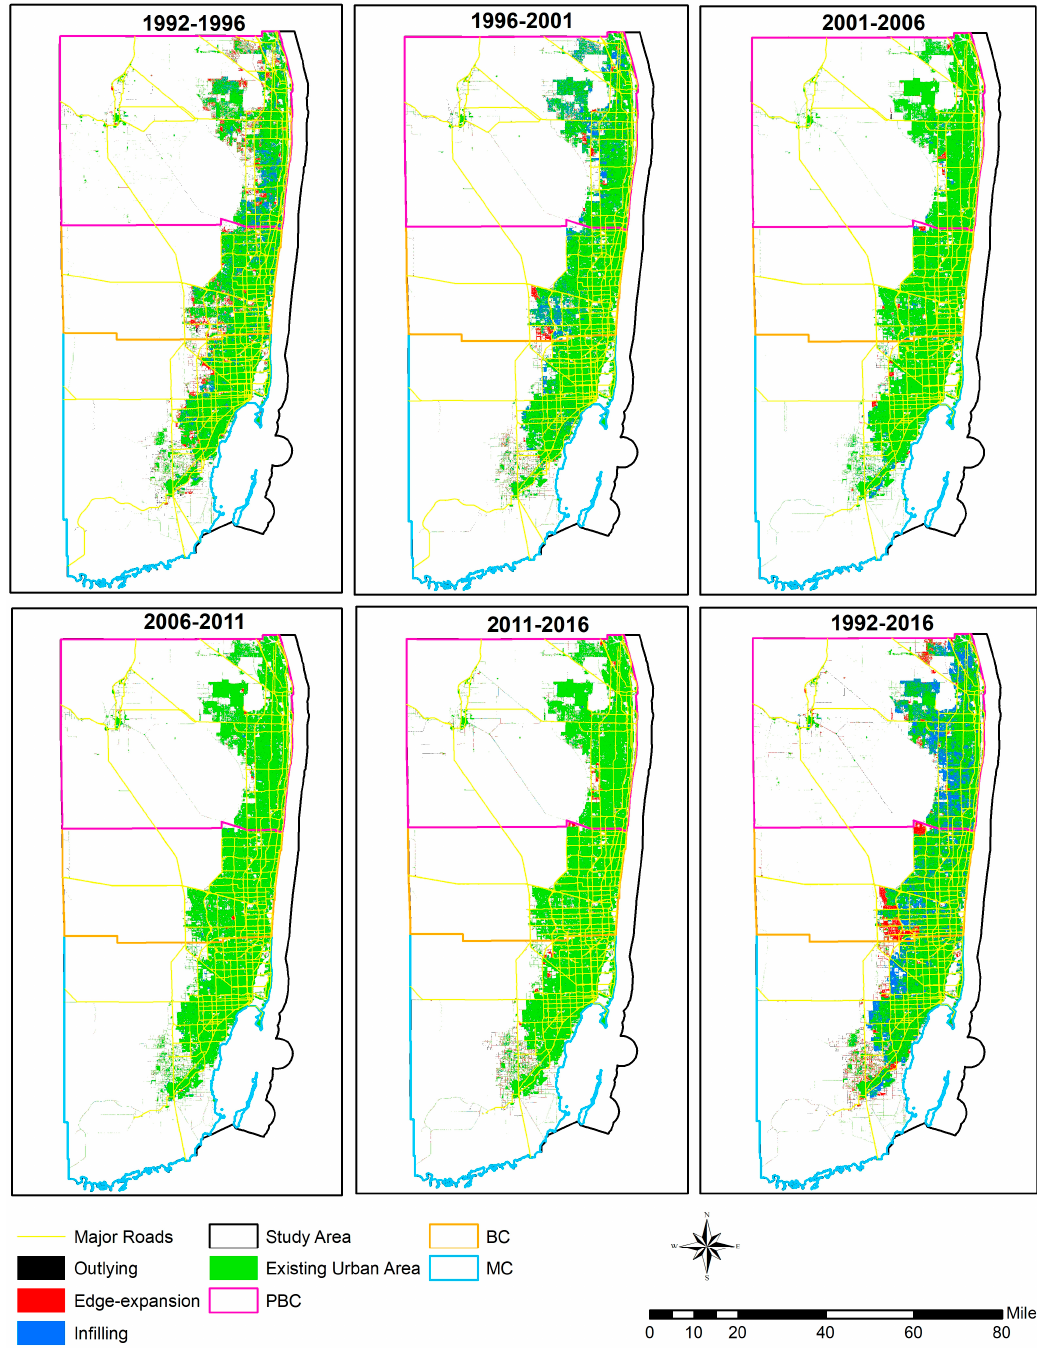
ff erent time periods in Miami